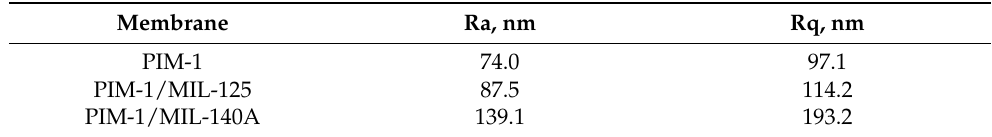
Table 1. Average (Ra) and root mean square (Rq) roughness values of the surface for nanofiltration- supported PIM-1 and PIM-1/MOFs membranes.